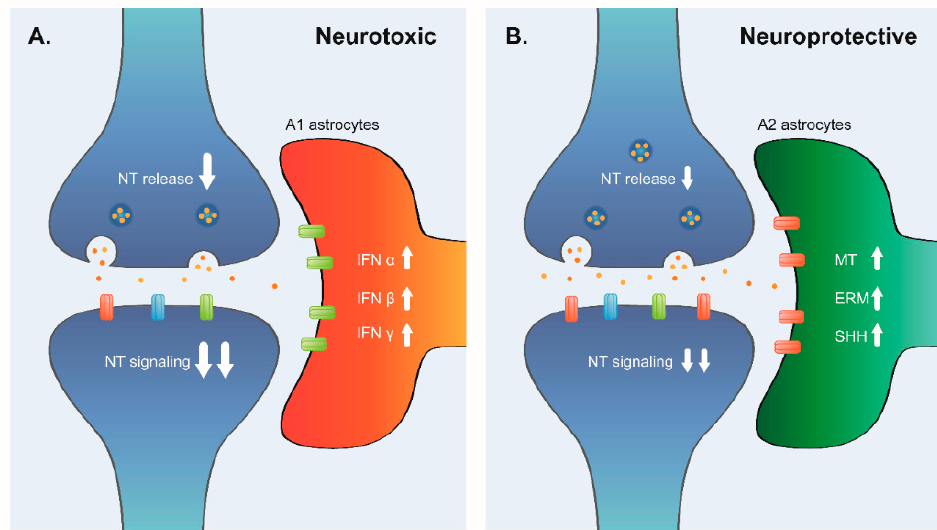
Figure 4. Model of tripartite synapse in elderly PFC. In elderly PFC, there is a down-regulation of expression of presynaptic genes in GABAergic and Glutamatergic synapses and down-regulation of postsynaptic genes in all kind of synapses. They are in two divergent environments ( A ). The presence of A1 astrocytes induces a neurotoxic phenotype; those astrocytes have an activation of inflammatory response represented by interferon pathways. ( B ) There are also A2 astrocytes in elderly PFC. A2 astrocytes have activation of metallothioneins, ERM and SHH pathways. Those pathways are pro-synaptogenic and neuroprotective, thus the alteration in the function of the synapses will be less severe than in ( A ).